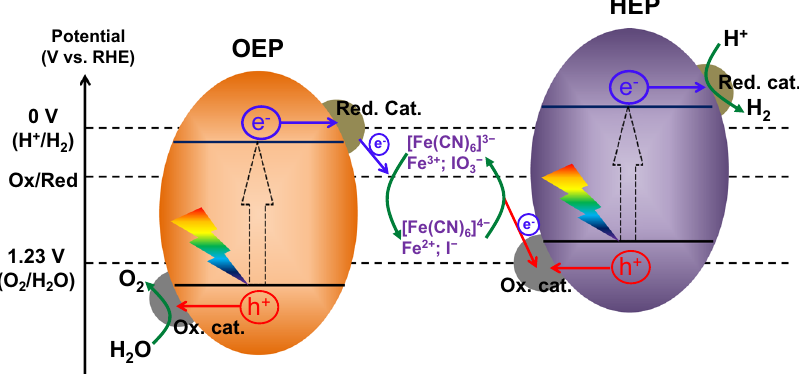
Fig. 1 The energy diagram for a two-step photoexcitation (also called Z-scheme) system with an aqueous redox mediator for overall water splitting. Red. cat.: reduction cocatalyst; O x . cat.: oxidation cocatalyst; RHE: reversible hydrogen electrode; HEP: H 2 -evolving photocatalyst; OEP: O 2 -evolving